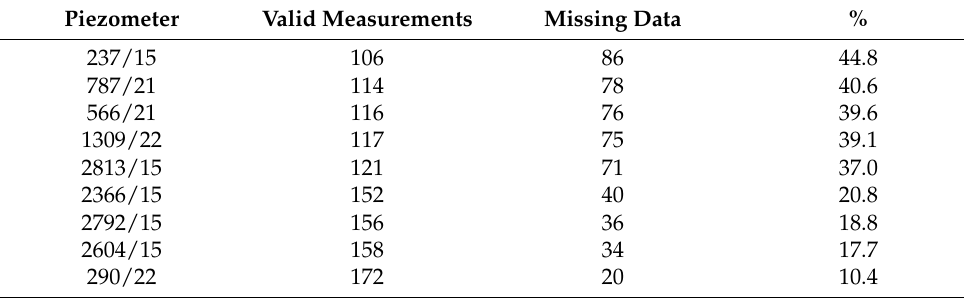
Table 3. Piezometers with gaps in their time series of groundwater level. Piezometer Valid Measurements Missing